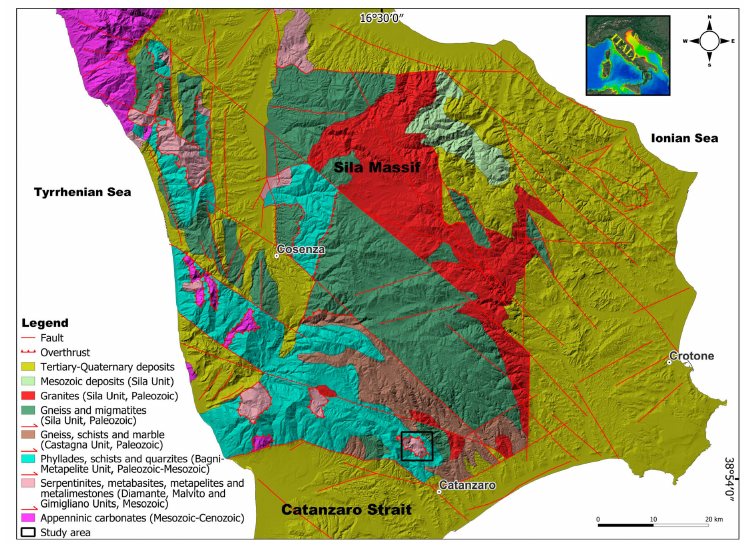
Figure 2. Schematic geological map of the northern Calabria. The black square in the southeastern sector indicates the location of the study area. Modified after Dijk et al. ii 2000 [53] and Tansi et al. ii 2007 [54].